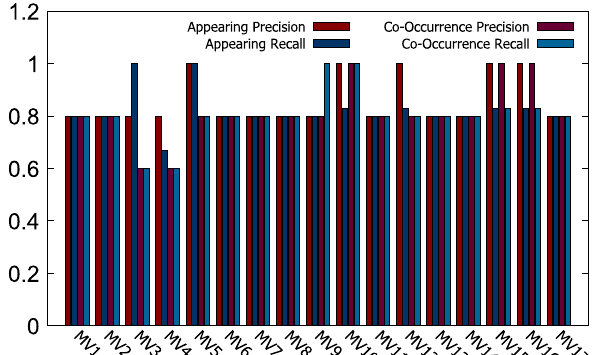
Fig. 5 Main characters’ precision and recall